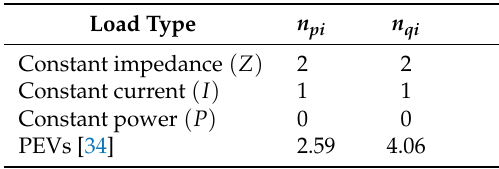
Table 4. Exponential indices value of load